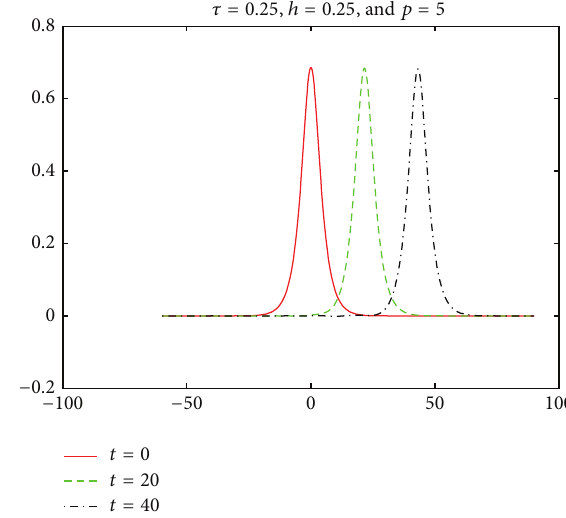
Figure 1: Wave graph of 𝑢(𝑥,𝑡) at various times when 𝑝 = 3 and 𝜏 = ℎ = 0.25 .